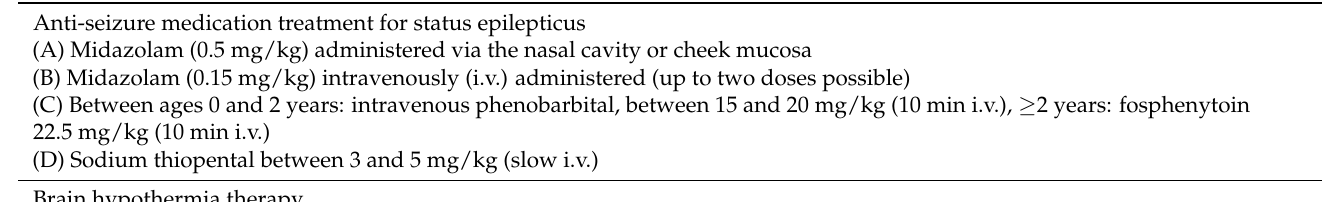
Table 4. Proposed protocol for brain hypothermia therapy (Dokkyo Medical University Hospital ICU: April 2014)